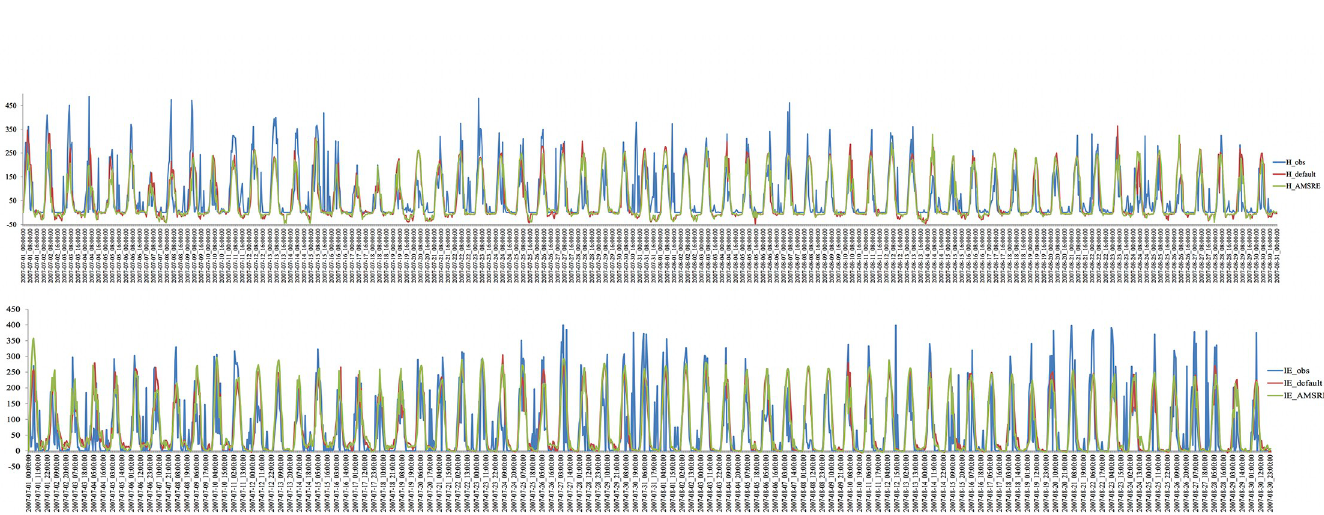
Fig 6. Comparisons of the sensible and latent heat fluxes obtained from the in situ data, default model configuration results and assimilation experiment (units: Wm-2).